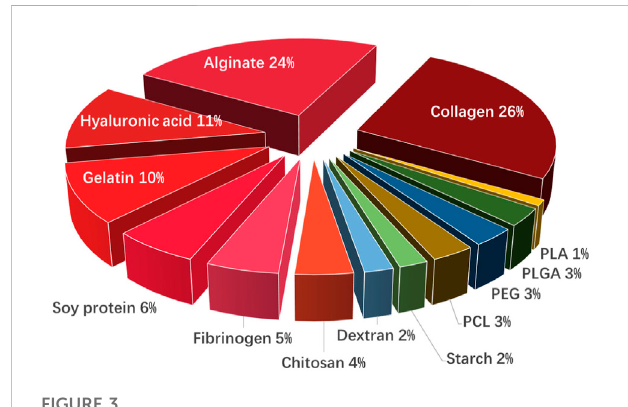
FIGURE 3 The proportion of natural biomass materials (red) and polymer in bioinks.